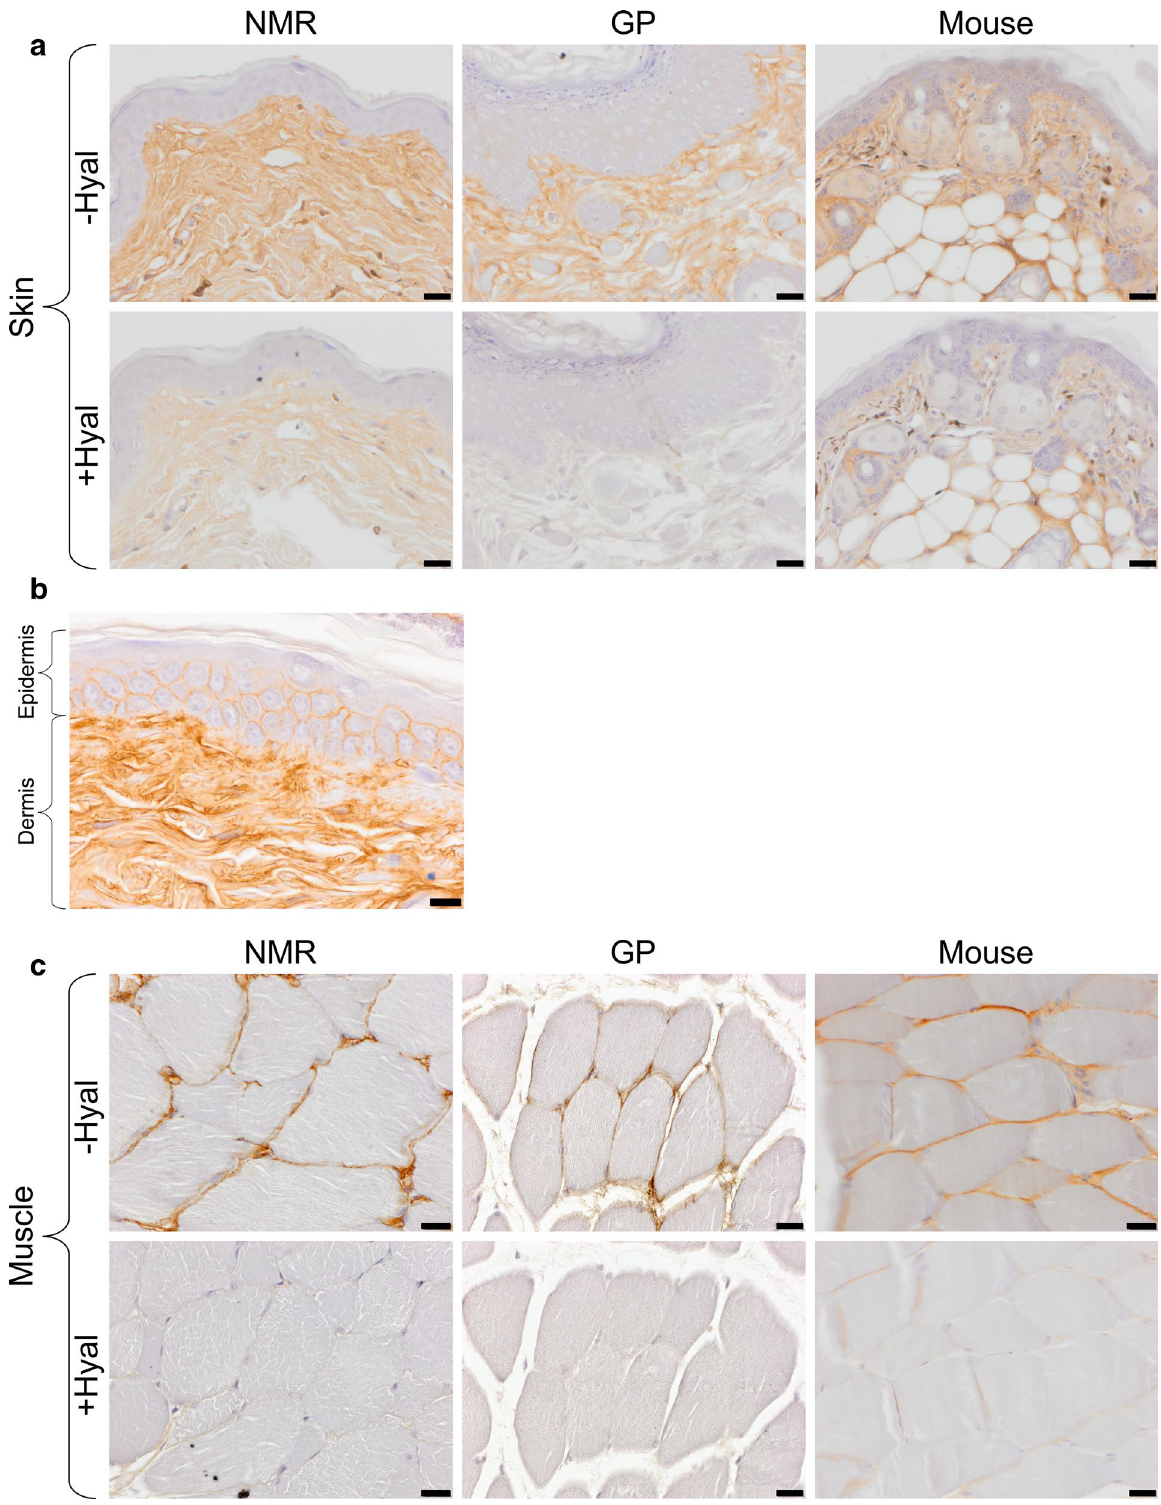
Figure 2. HA staining of NMR, GP, and mouse tissues. ( a , b ) skin; ( c ) muscle; ( d ) kidney cortex; ( e ) kidney medulla; ( f , g ) lymph node. All tissues were stained using a HA binding protein followed by peroxidase detection, with (+) or without (−) 3-h incubation with 100 U/ml hyaluronidase from Streptomyces hyalurolyticus . Positive signals are revealed in brown. Scale bars, 20 µm ( a , c , d , f ), 10 µm ( b ) and 100 µm ( f ). NMR naked mole-rat, GP guinea